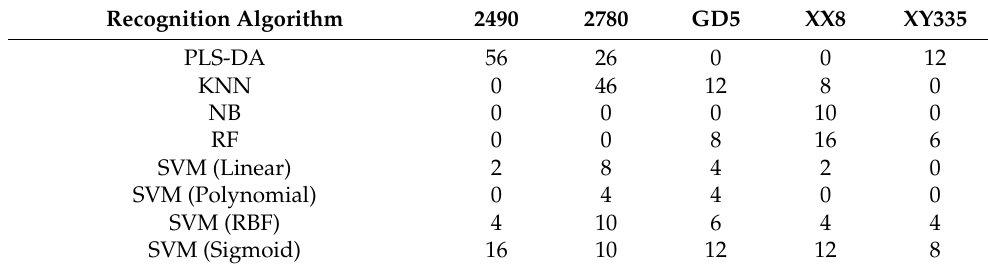
Table 7. The omission